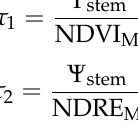
, ρ , ρ , ρ , ρ and 𝜌 are the bottom of b3 b4 b5 b8 b11 b12